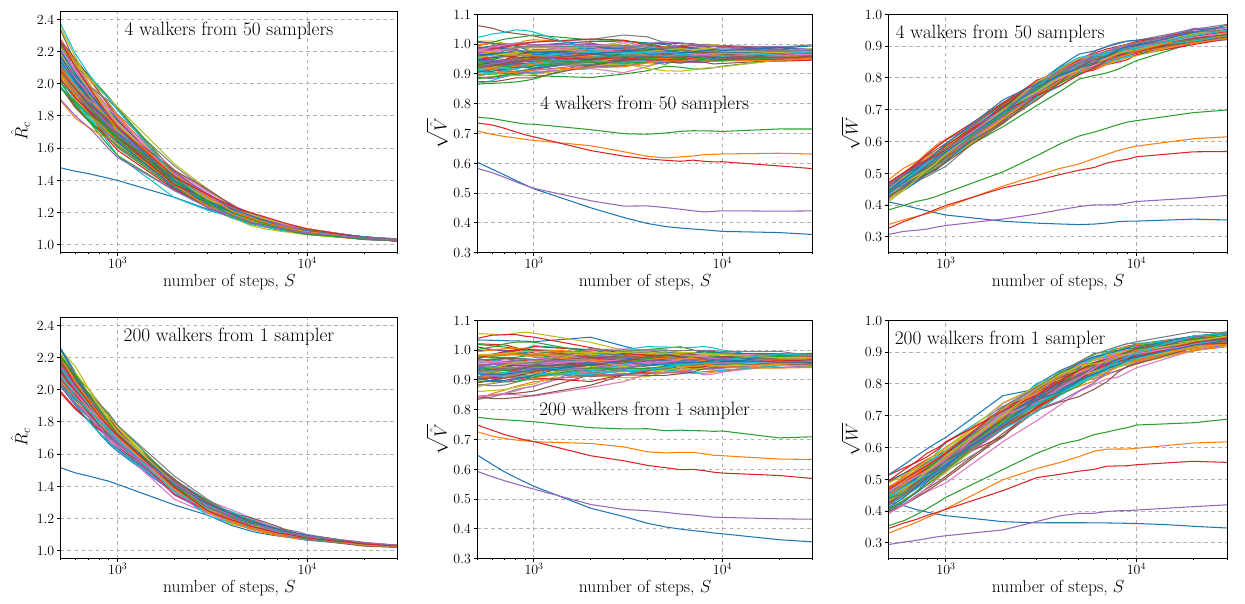
(cid:11) √ ˆ V , and W walkers each. Lower panel: Same plots made using 200 walkers from a single sampler. The different lines in the plots represent the 95 different parameters of the LF